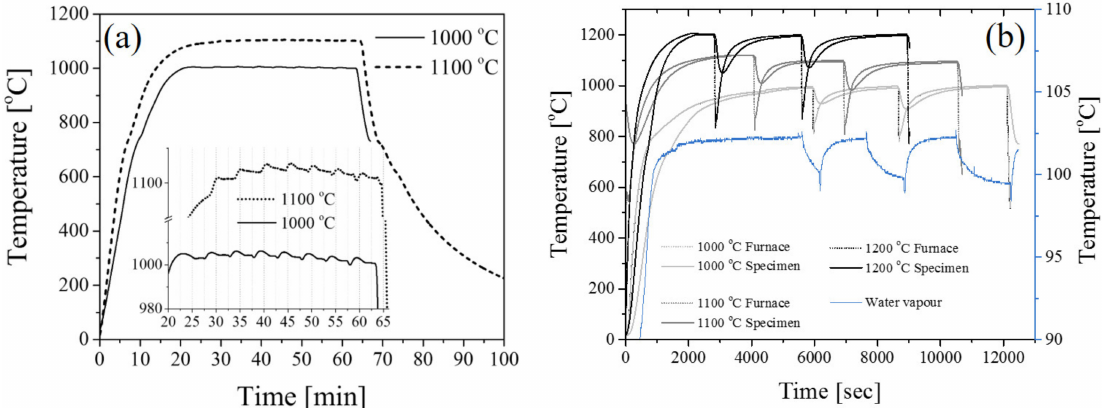
Figure 6. Experimental setup for oxidation under the water vapor atmosphere.